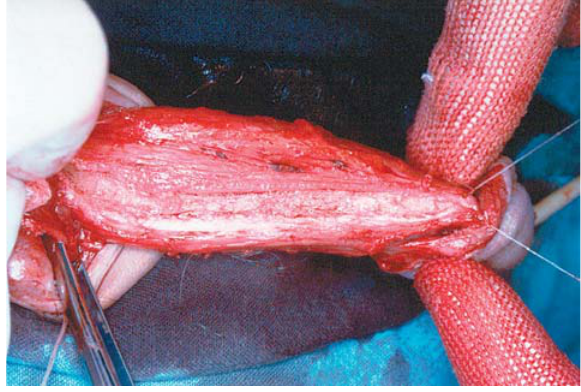
Figure 3 – Ventral face of the left corpus cavernosum. A band in the tunica albuginea has been removed.